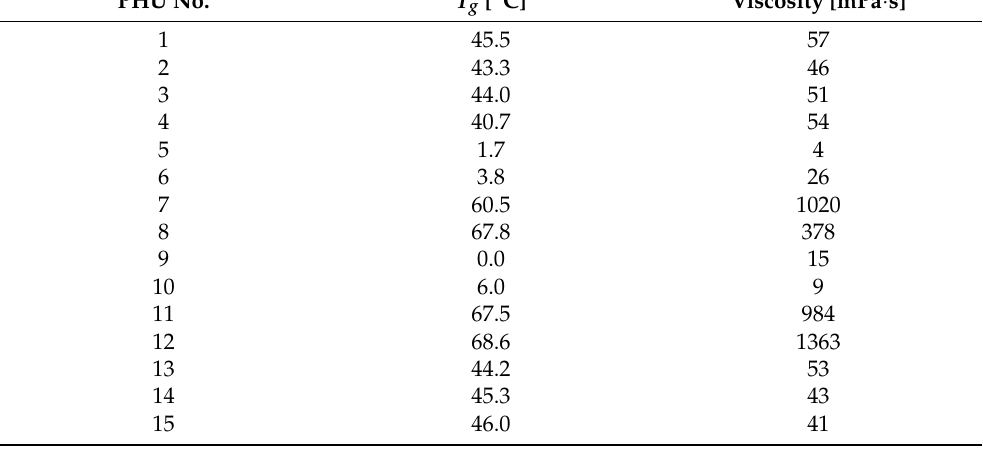
Table 5. Glass transition temperatures ( T g s) and viscosity at 140 ◦ C for the investigated PHUs. PHU No.